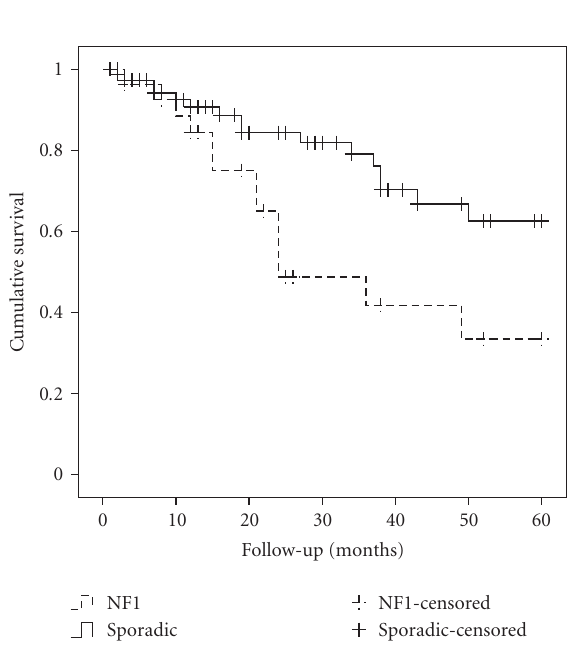
Figure 2: Kaplan-Meier survival in patients without metastases at